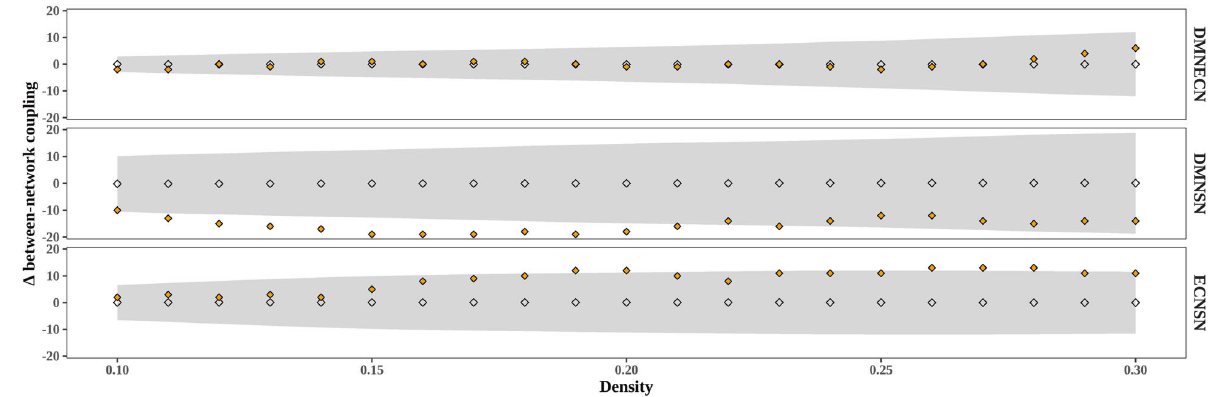
Fig. 2 Difference in between-network maturational coupling between preterm-born infants exposed to high versus low stress (median split) across density levels. Positive values show high stress >low stress and negative values show low stress >high stress. Gray diamonds depict the permutation distribution of average maturational coupling, gray bands depict 95% con fi dence interval, and orange diamonds depict the group-level difference score.